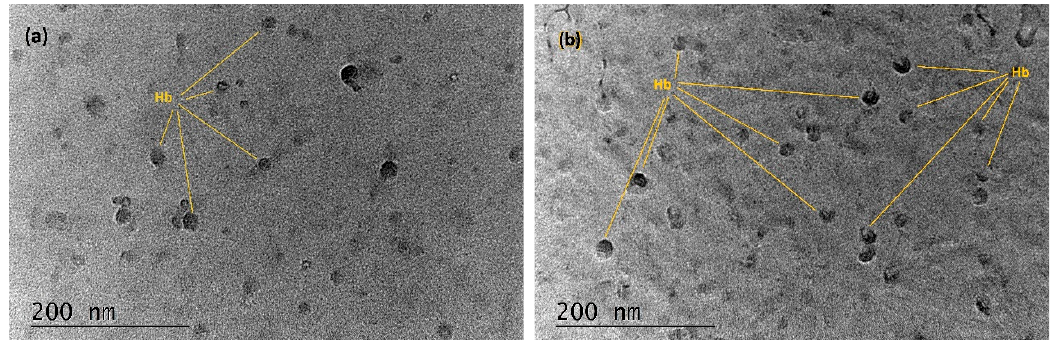
Figure 5. TEM images of ( a ) the Hb film deposited by spin coating; ( b ) the MAPLE-deposited Hb film.